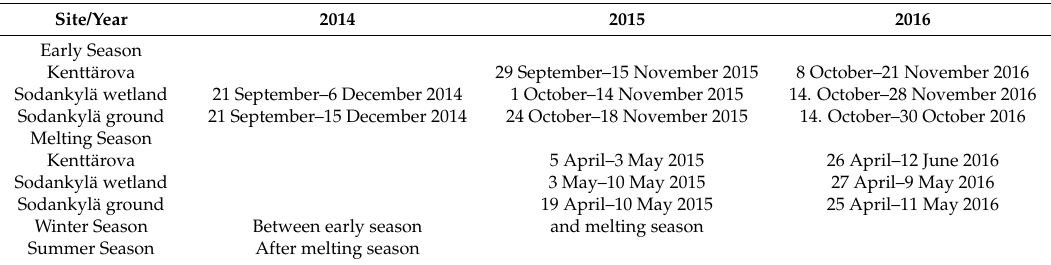
Table 2. Definition of Seasons.